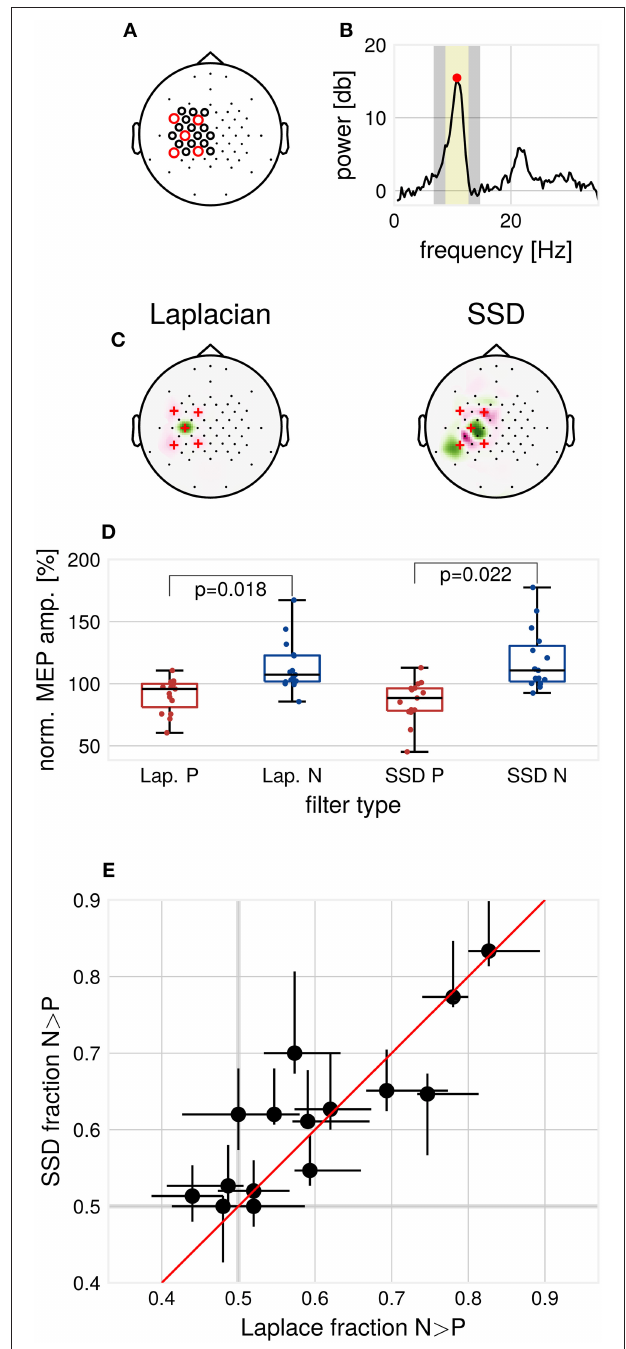
FIGURE 1 | Methods and results. (A) EEG cap layout. Channels used for estimation of the individual spatial filters are marked with circles. Red circles indicate the channels used for determination of individual µ -peak-frequency. (B) Example 1/f-corrected spectrum used for determination of individual µ -peak frequency. Frequency bands used for the computation of SSD filters. Marked in yellow are the individual µ -peak frequency ± 2Hz, in gray the flanking noise frequency bands. (C) Example SSD spatial filter (right) computed from resting state EEG activity and the standard C3-centered Laplacian filter (left). (D) Group median MEP amplitudes for the respective (Continued)